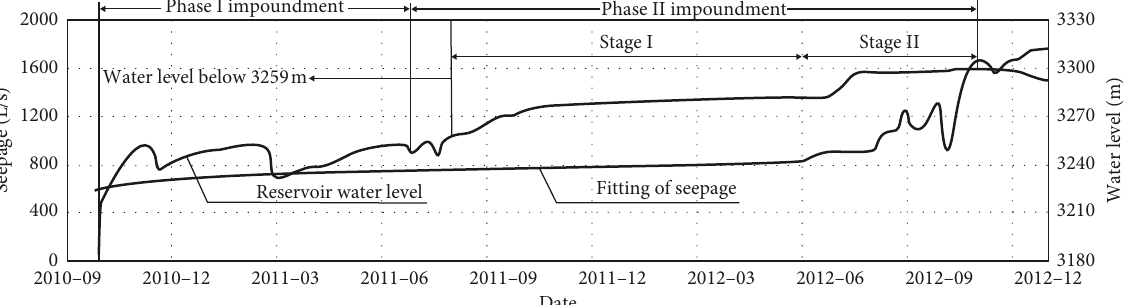
Figure 11: Variations in seepage measured at the weir.